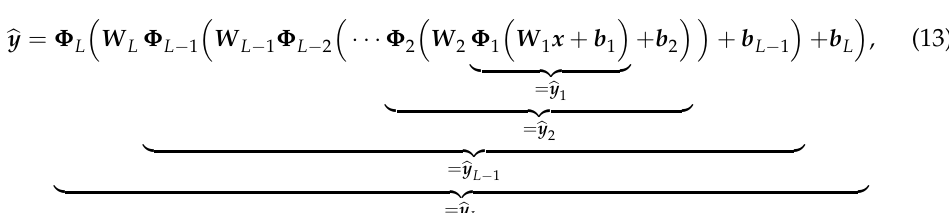
Figure 7. Illustration of different activation functions and their derivatives, i.e., ( a ) Φ ( x ) = Φ ( b ) Φ ( x ) = Φ tanh ( x ) , ( c ) Φ ( x ) = Φ sgn ( x ) , ( d ) Φ ( x ) = Φ id ( x ) , ( e ) Φ ( x ) = Φ ReLU ( x ) and ( f ) Φ ( x ) = Φ ( x ) (for mathematical definitions, see Table sat